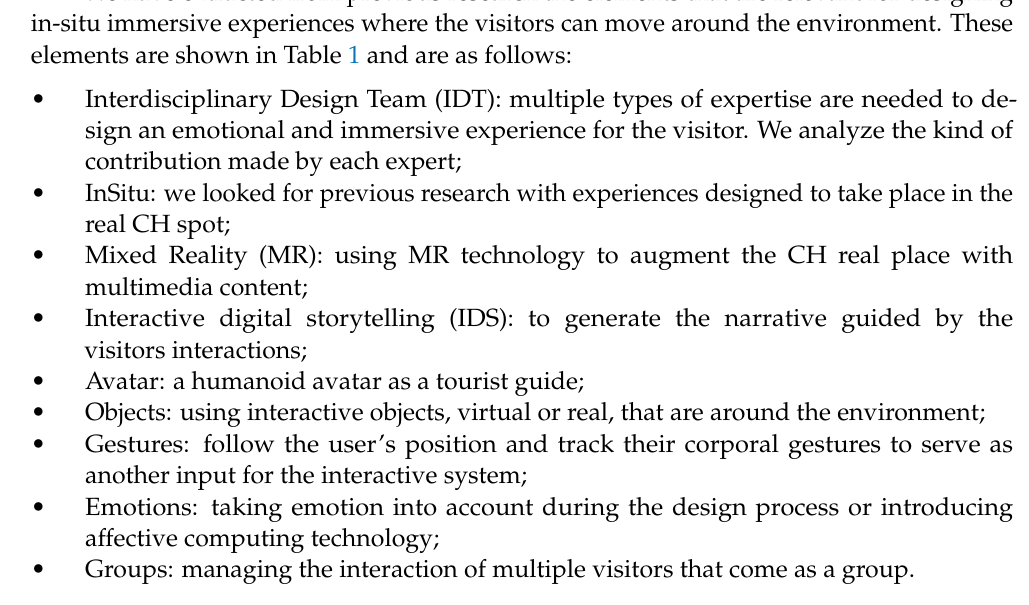
Table 1. Features of Interactive Cultural Heritage found in existing